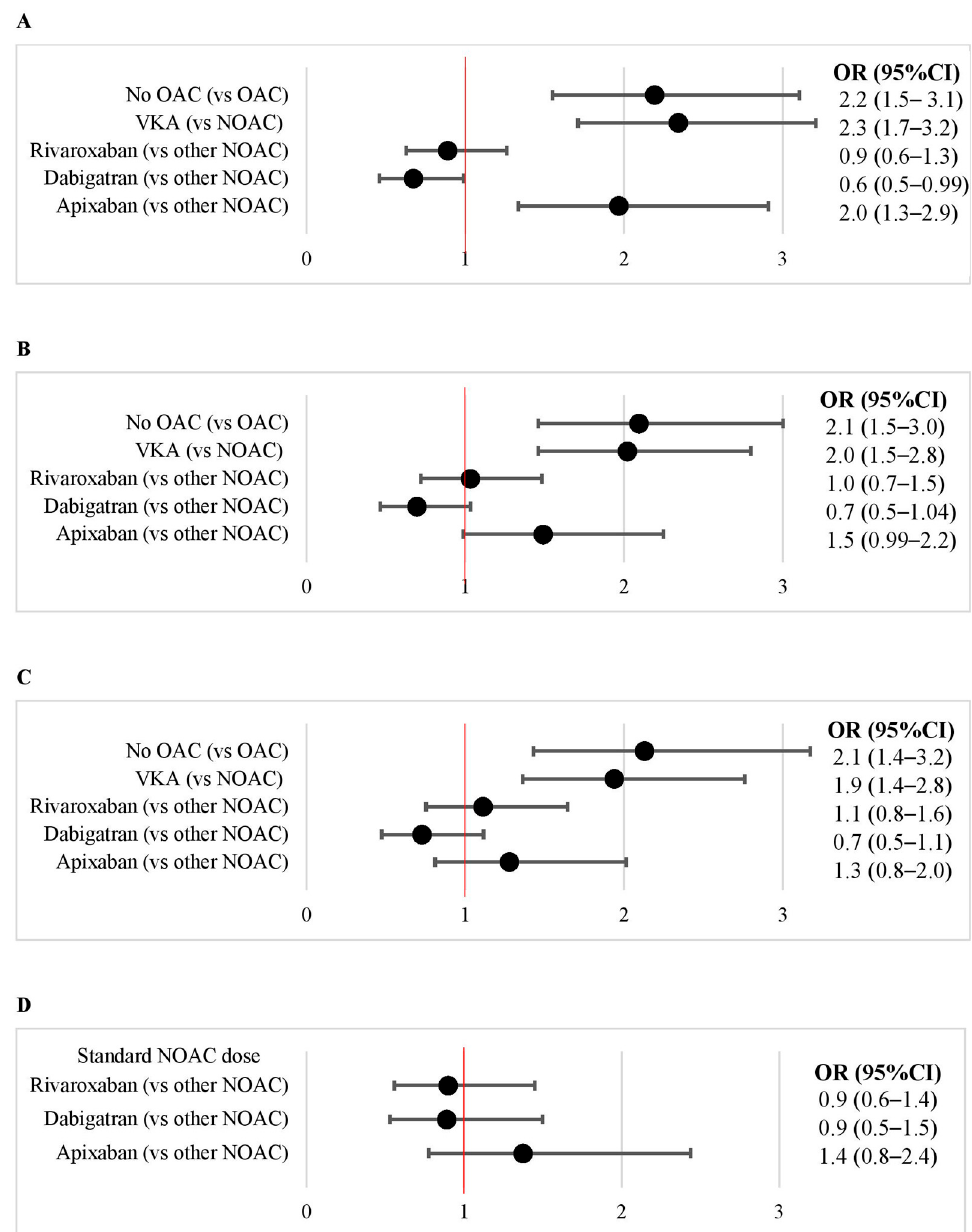
Figure 3. Risk of left atrial thrombus in patients with atrial fibrillation/flutter in relation to oral anticoagulation. ( A ): Unadjusted. ( B ): Adjusted for age, sex, heart failure, hypertension, diabetes, vascular disease, and previous ischemic stroke/TIA/systemic embolism. ( C ): Adjusted for age, sex, heart failure, hypertension, diabetes, vascular disease, previous ischemic stroke/TIA/systemic embolism, atrial fibrillation/flutter type (non-paroxysmal vs. paroxysmal), glomerular filtration rate, and antiplatelets. ( D ): In patients on standard doses of NOACs. Adjusted for age, sex, heart failure, hypertension, diabetes, vascular disease, previous ischemic stroke/TIA/systemic embolism, atrial fibrillation/flutter type (non-paroxysmal vs. paroxysmal), glomerular ejection fraction, and antiplatelets. Abbreviations: CI, coincidence interval; NOAC, non-voitamin K oral anticoagulant; OAC, oral anicoagulation; OR, odds ratio; VKA, vitamin K antagonist.